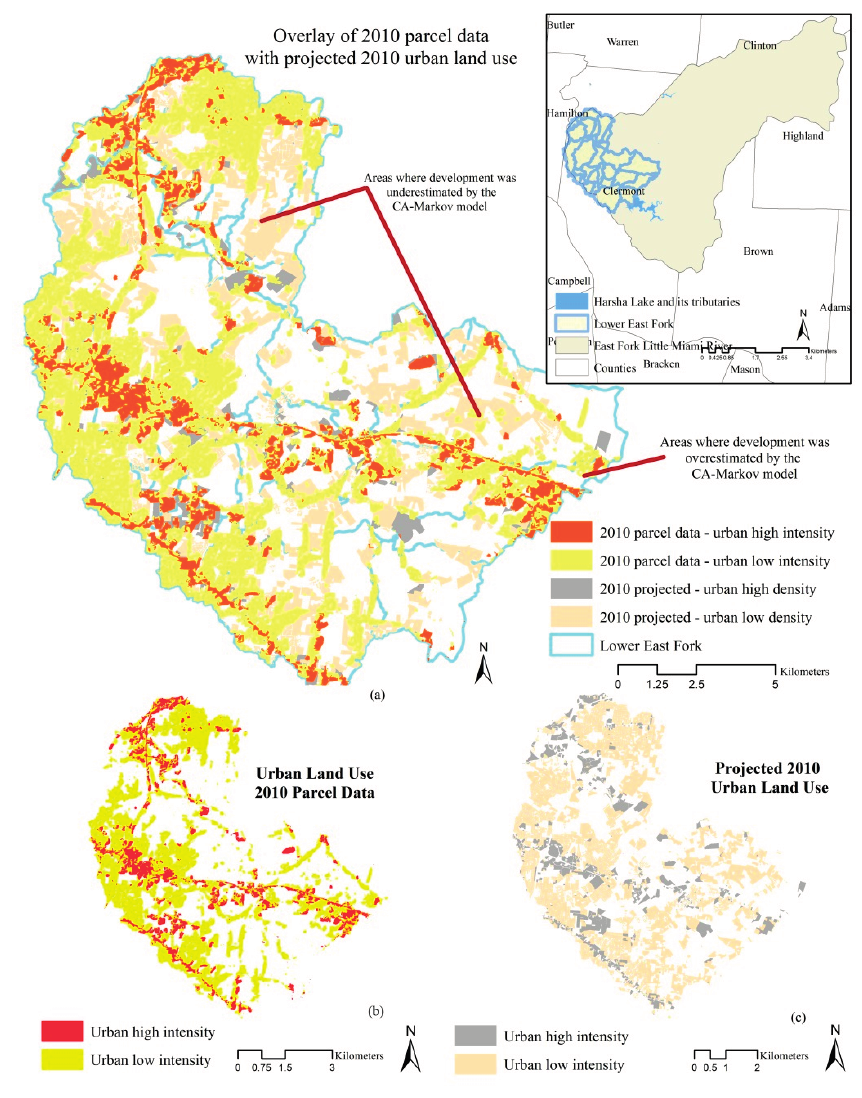
Figure 4. Comparison of 2010 parcel data for the rapidly urbanizing Lower East Fork with the 2010 projected land use change. Top left , map ( a ) overlay of maps (b) and (c); Lower left , map ( b ) urban high and low density areas as derived from the 2010 parcel data; Lower right , map ( c ) projected urban high and low density areas.